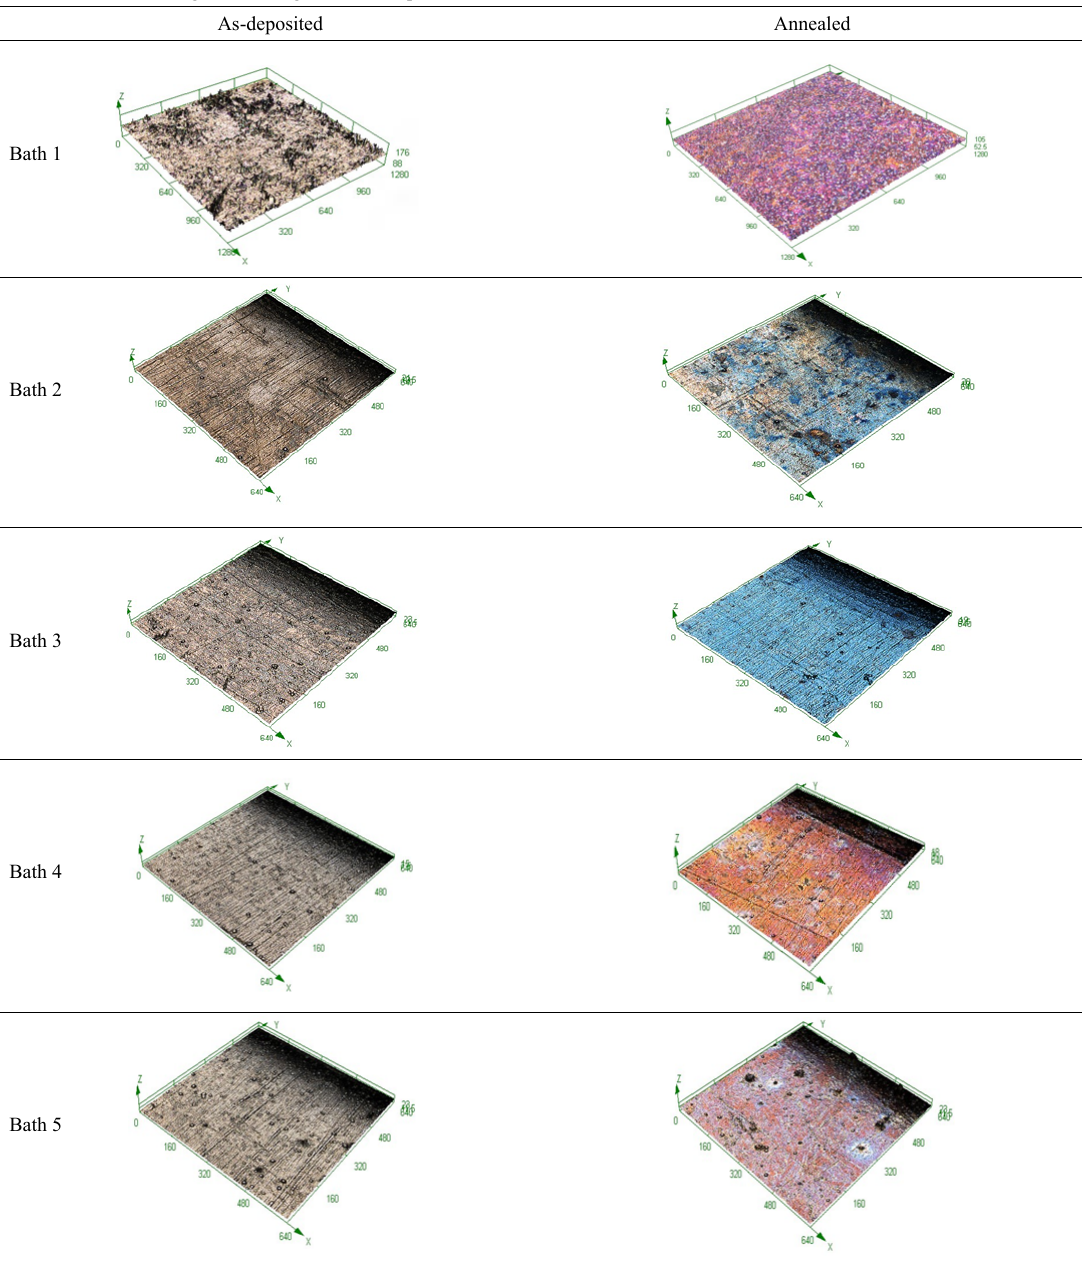
Table 6. 3D CLSM images of coatings in the as-deposited and annealed conditions.